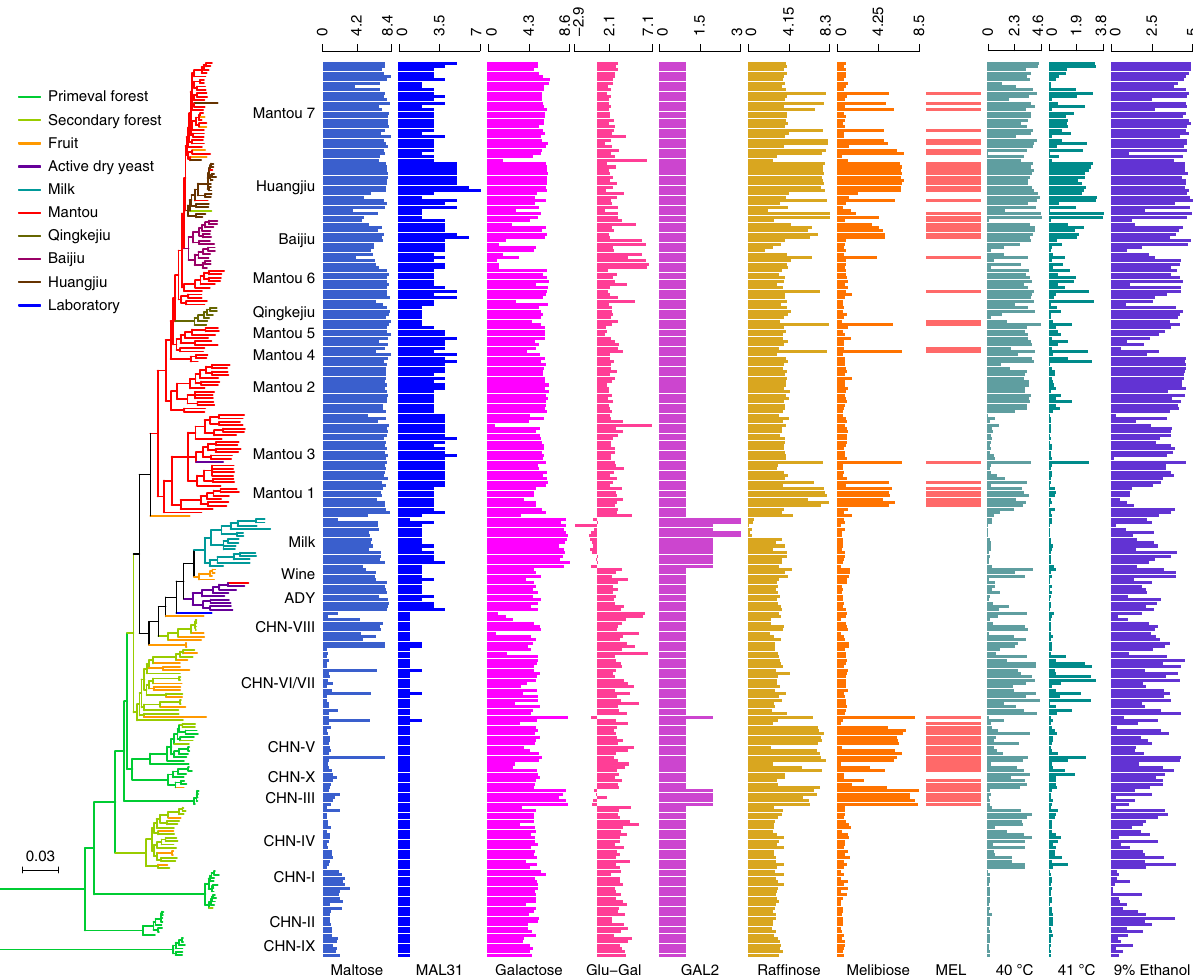
Fig. 5 Phenotypic traits and associated gene copy-number variations (CNVs) of wild and domesticated isolates of S. cerevisiae . Isolates are represented by terminal branches in the phylogenetic tree constructed from maximum likelihood analysis on genome wide SNPs and are colored according to their ecological origins. Bar charts with labels at the bottom re fl ect phenotypic traits or CNVs. Maltose, Galactose, Raf fi nose, and Melibiose indicate growth rate (×1000) in the medium with each of the sugars as the sole carbon source; Glu-Gal indicates difference between the growth rates in glucose and in galactose; MAL31 and GAL2 indicate CNV of each of the genes; MEL1 indicates presence (solid bar) or absence (blank) of the gene; 40 °C, 41 °C, and 9% ethanol indicate growth ef fi ciencies under the